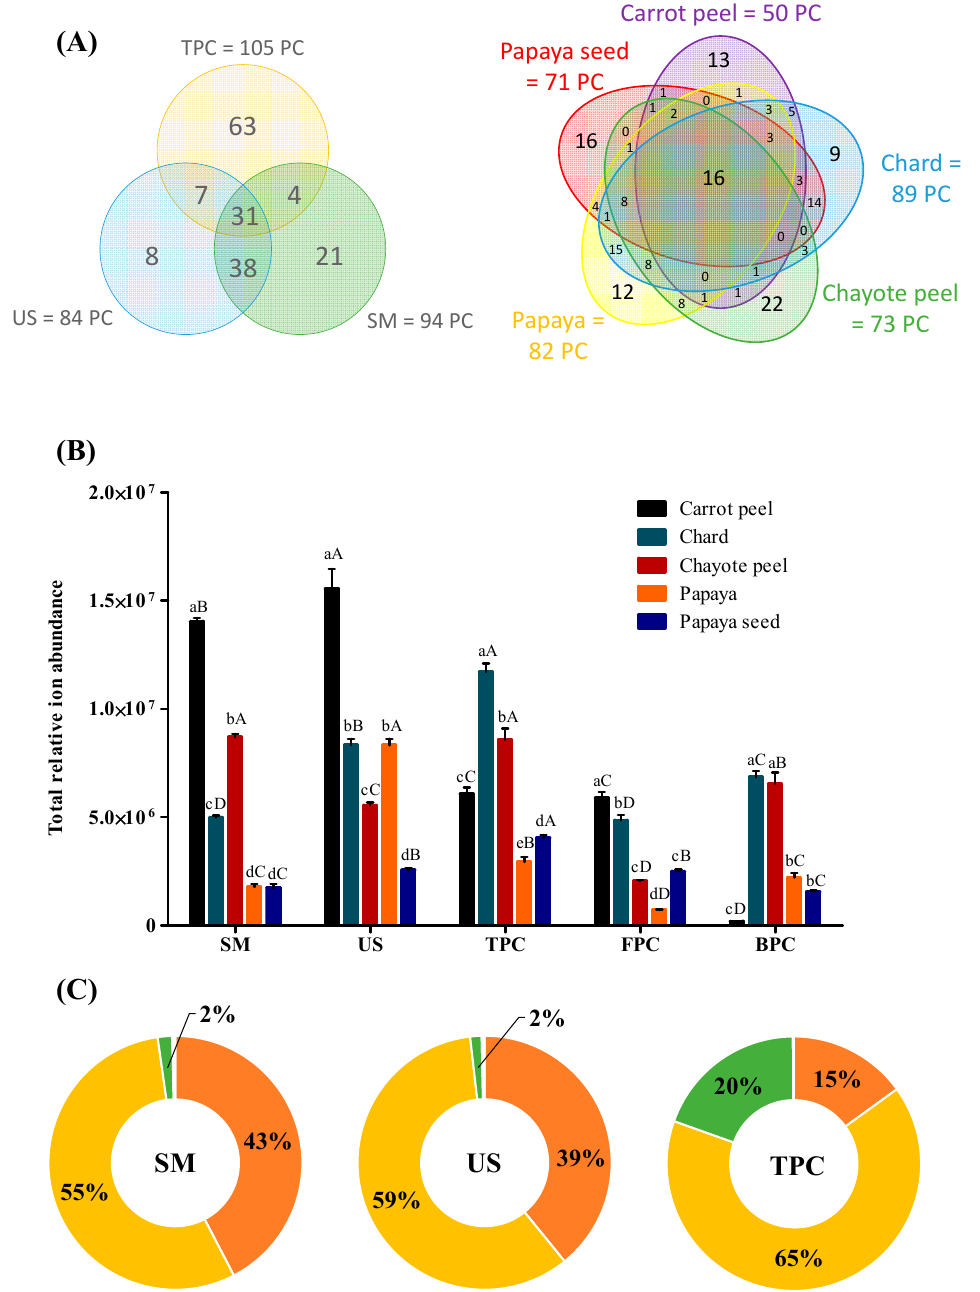
Figure 3. Metabolomics analysis: ( A ) Venn diagram with the number of identifications distribution in each extract and in each of the fruit and vegetable by-products (FVB); ( B ) total relative ion abundance of phenolic compounds with the sum ( Σ ) of each extract; ( C ) distribution of phenolic classes in selected mixture (SM), ultrasonication (US) and total phenolic content (TPC) extracts. Different lowercase letters mean a significant difference ( p < 0.05) between FVB with the same extractor, while uppercase letters mean a significant difference ( p < 0.05) between extracts from the same FVB. Bars represent standard deviation ( n = 3).